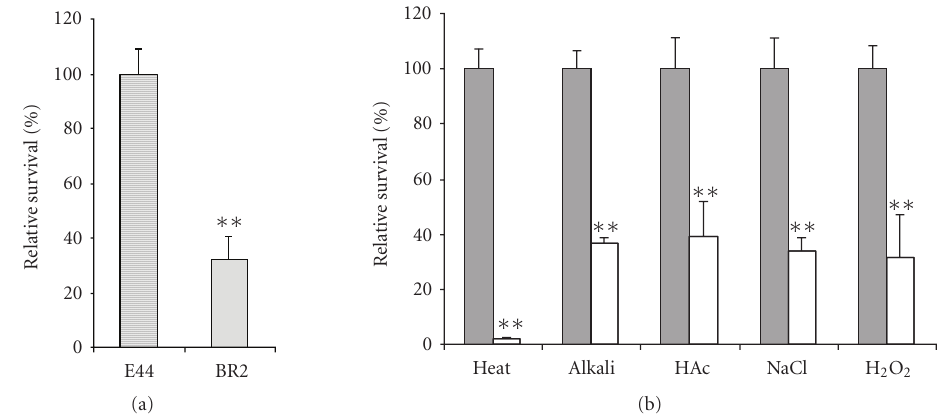
Figure 5: The relative survival rate of the BR2 mutant comparing with E44 . (a) Both strains in stationary phase without any stress treatment, (b) both strains were tested with di ff erent environmental stress including heat shock (54 ◦ C for 3 minutes), alkali (Tris pH = 10.0 for 30 minutes), acid endurance (acetic acid, pH = 2.8 for 20 minutes), high osmolarity challenge (2.4M NaCl for 1 hour), and oxidative stress (10 μ M H 2 O 2 for 30 minutes). Gray columns: E44; white columns: BR2. Columns marked with ∗∗ are significantly di ff erent ( P < .